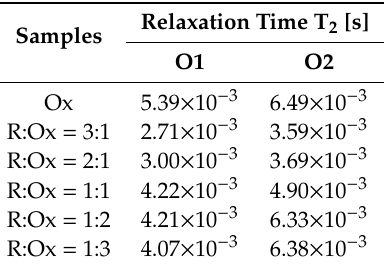
Figure 1. Trend of spin–spin relaxation time of oils and extenders: ( a ) O1 and O1-R blends; ( b ) O2 and O2-R blends. Table 2. T 2 relaxation time of the O1, O2, and extenders.